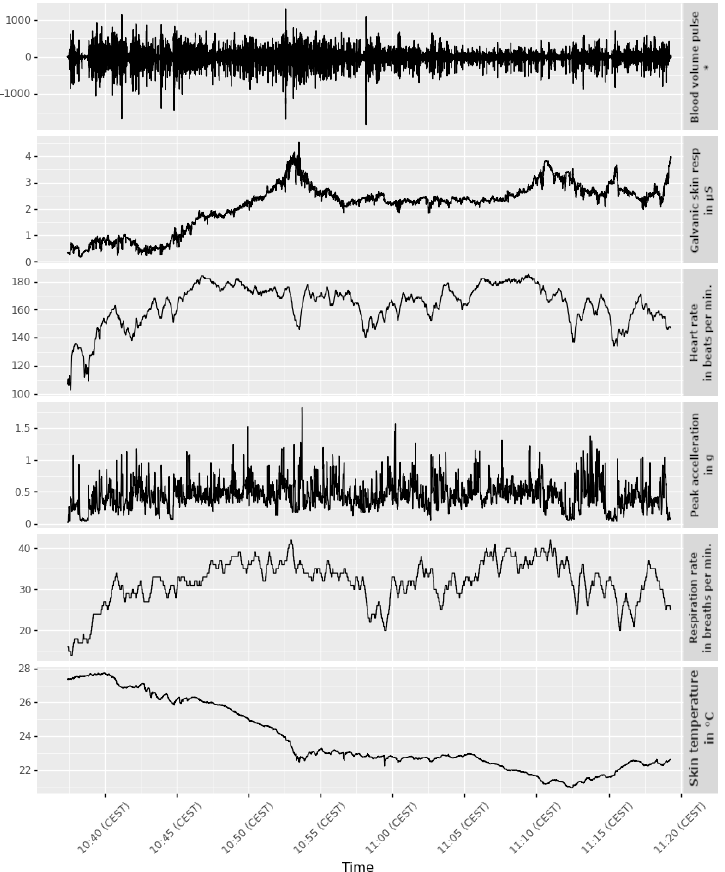
Figure 5. Example of measured physiological data. The asterisk in the subplot of the blood volume pulse indicates that this is a unitless measure.